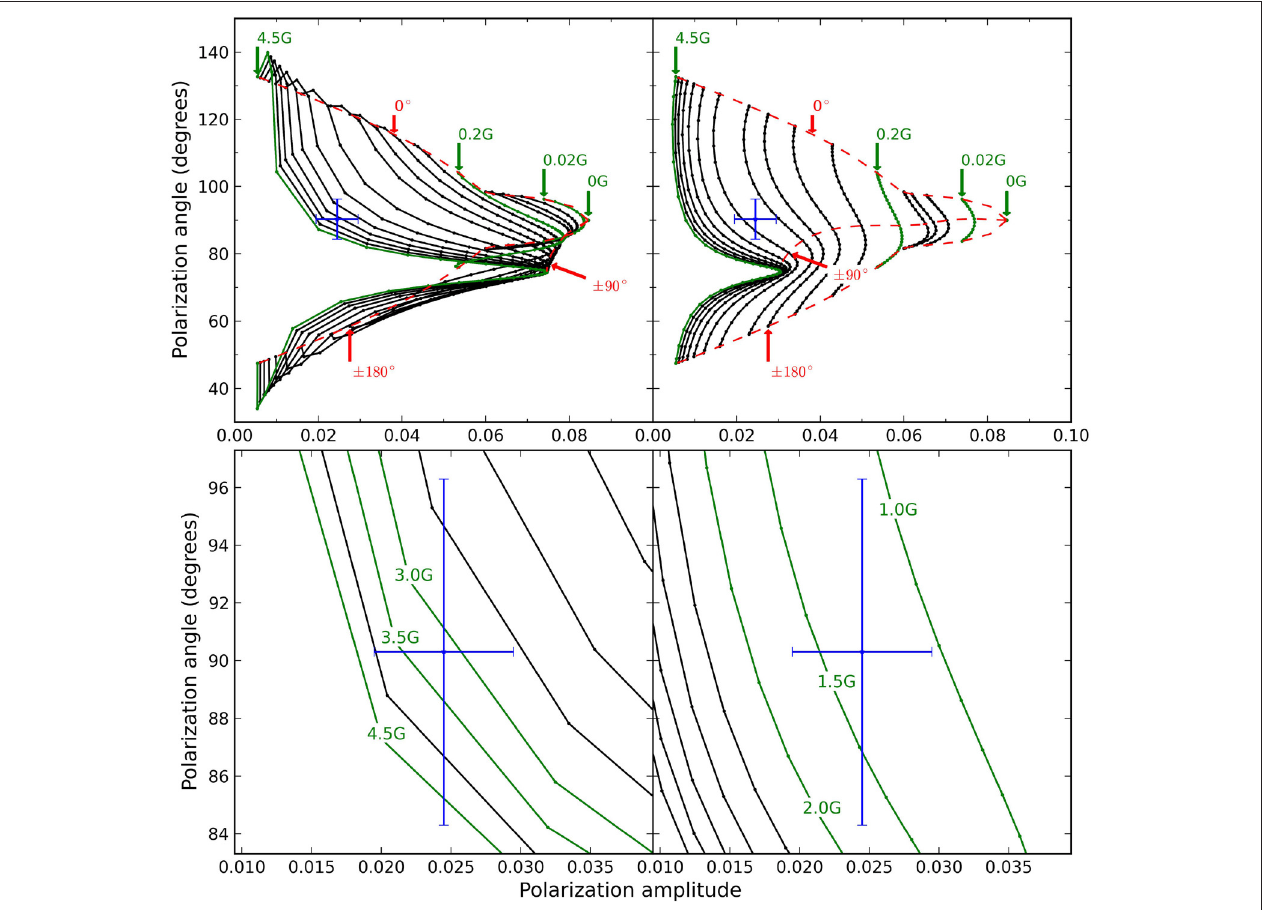
FIGURE 4 | The same as Figure 3 for the Field II model grids. For the bottom panel only the B-isocontours spaced by 0.5G are drawn. For Field II the HeI1083 polarization measurement intersects both model grids which is consistent with inclination solutions inside the Van Vleck uncertainty region.